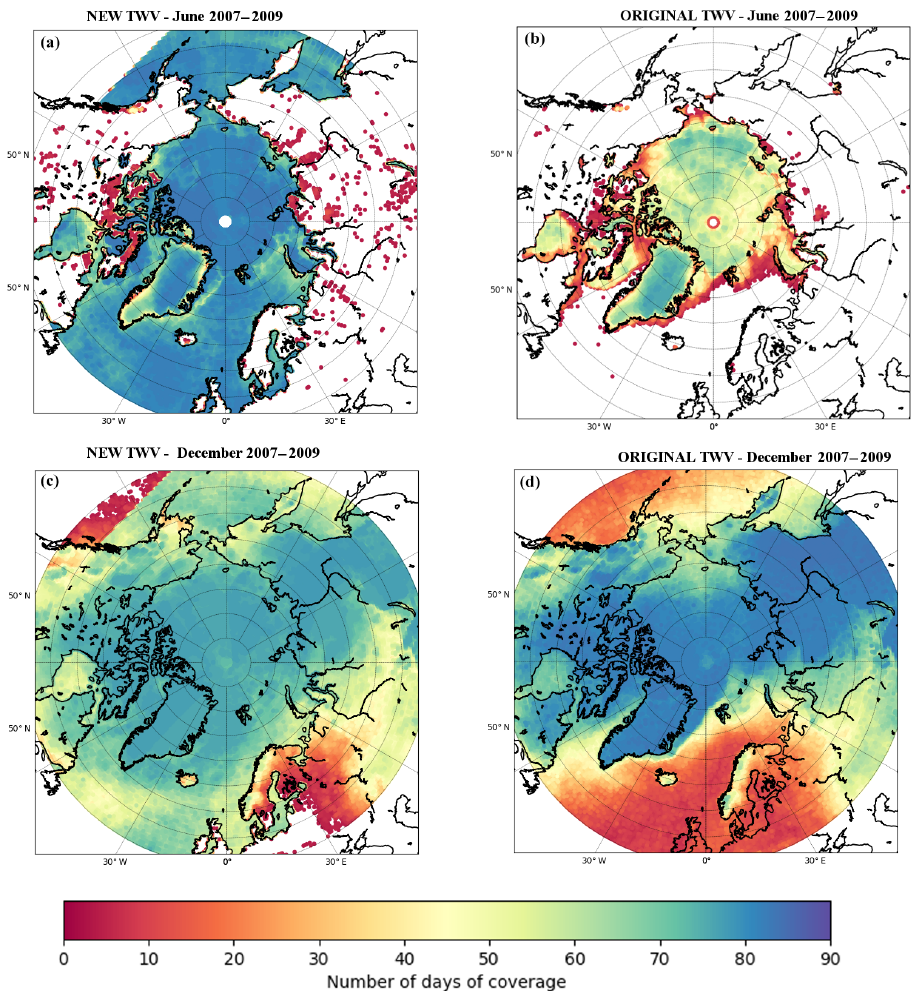
Figure 5. Number of days of coverage for the Northern Hemisphere for one typical summer and one winter month, over 3 years. Panels (a) and (b) represent the month of June for the 2007–2009 interval, while panels (c) and (d) represent December for the same 3 years. Panels (a) and (c) show results for the new algorithm, while (b) and (d) show results for the original AMSU-B